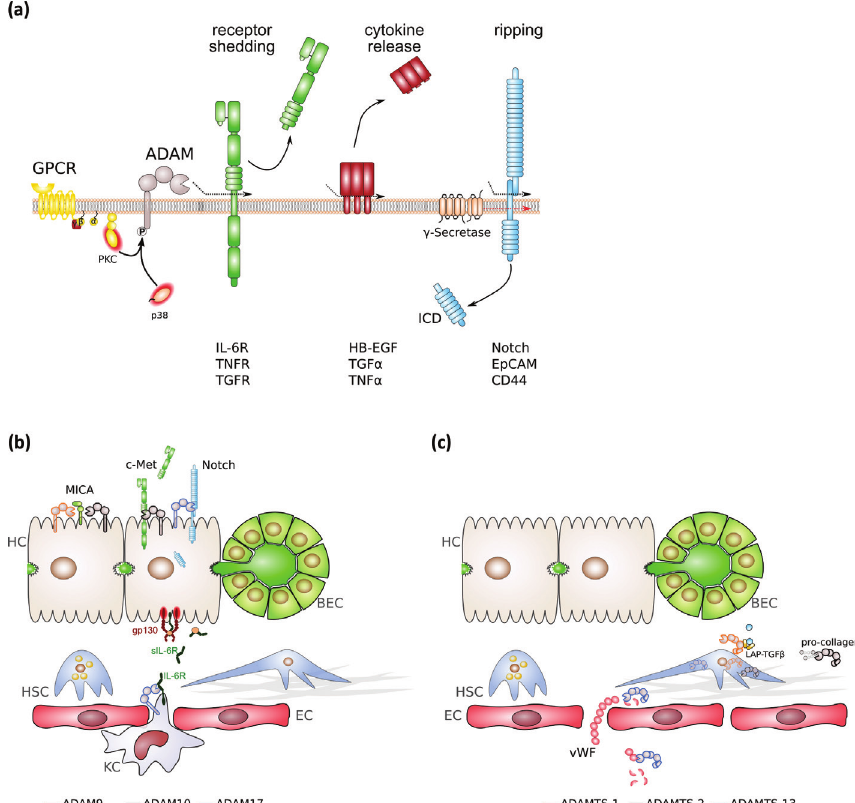
Figure 2. Signal activities of ADAM and ADAMTS proteinases in the liver. (a) ADAM protease activity, ADAM17 in particu- lar, can be regulated by protein phosphorylation. Active ADAM proteases are involved in the release of receptor ectodomains, thereby blunting receptor signalling in most of the cases, the release of membrane-bound cytokines and the initiation of intracel- lular signalling by regulated intramembrane proteolysis (RIP). (b) Selected proteolytic events of the indicated ADAM proteinases in different cell types of the liver. (c) Selected proteolytic and non-proteolytic events of the indicated ADAMTS proteinases in different hepatic cell types. BEC, biliary epithelial cells; EC, endothelial cell; gp130, glycoprotein 130; HSC, hepatic stellate cells; HC, hepatocyte; ICD, intracellular domain; IL-6R, interleukin 6 receptor; KC, Kupffer cell; LAP-TGF β , latency-associated peptide-transforming growth factor β ; MICA, MHC class I polypeptide-related sequence A; sIL-6R, soluble IL-6R; vWF – von Willebrand